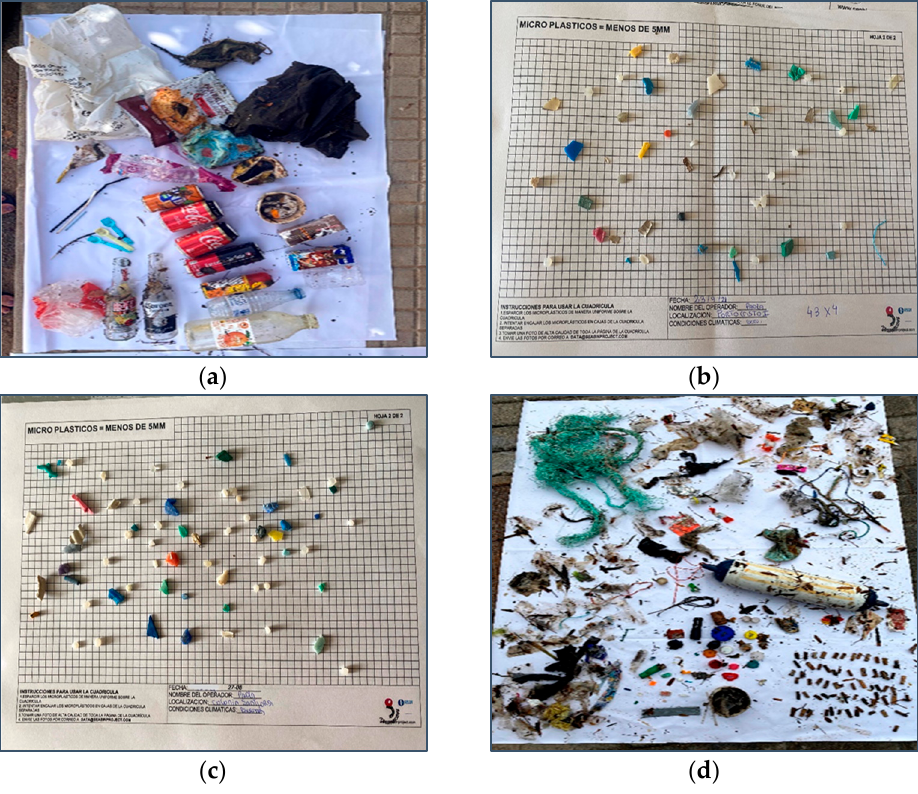
Figure 5. Various marine litter and microplastics collected by the seabin device in Port of Colonia de Sant Jordi ( a , b ) and Port of Cristo ( c , d